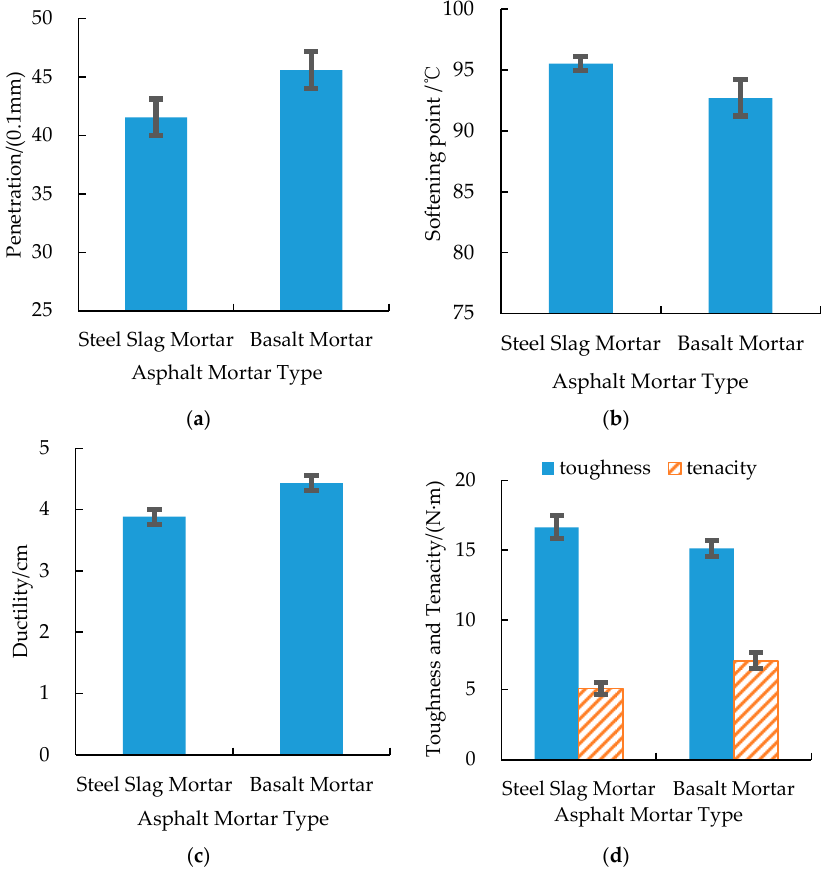
Figure 1. Physical properties of the asphalt mortar: ( a ) Penetration; ( b ) Softening Point; ( c ) Ductility; ( d ) Toughness and Tenacity.